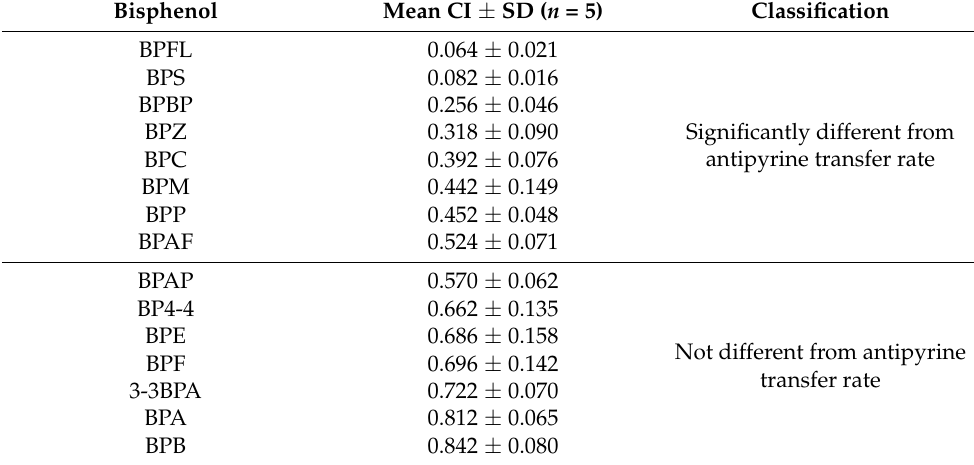
Table 1. Mean ± standard deviation (SD) of CI of the 15 studied BPs (seven BPs with transfer rates that did not differ significantly from that of antipyrine and eight BPs with a significantly lower transfer rate than that of antipyrine) evaluated on five placentae. The clearance index corresponds to the ratio of BP-studied placental transfer rate divided by the antipyrine transfer rate